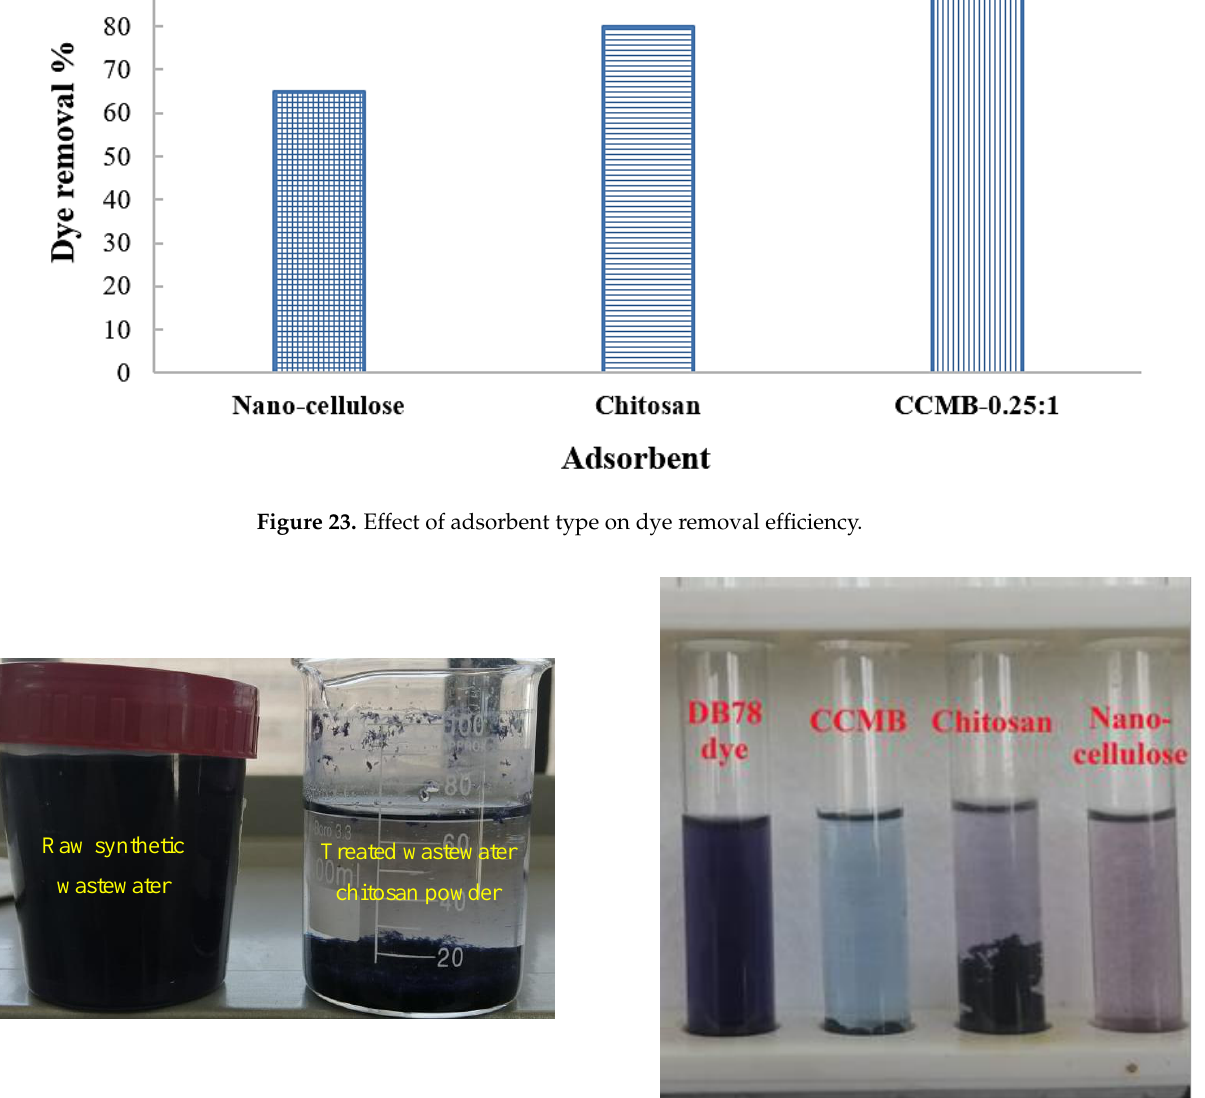
Figure 24. The adsorption process of DB78 dye by using adsorbents (chitosan, nanocellulose, and CCMB-0.25:1).